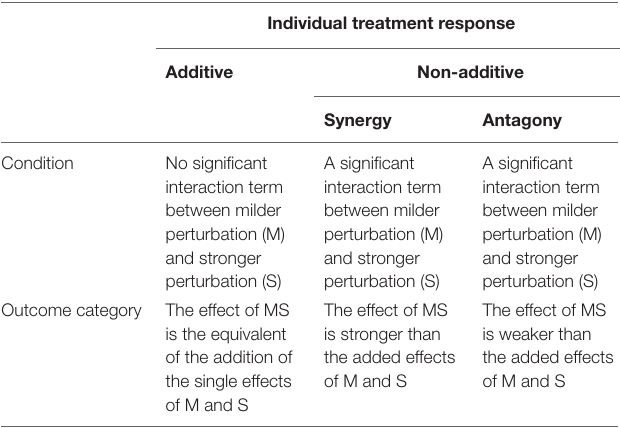
TABLE 1 | Interaction types describing the outcome of multiple stressors (perturbations) following Crain et al. (2008) and Côté et al. (2016).